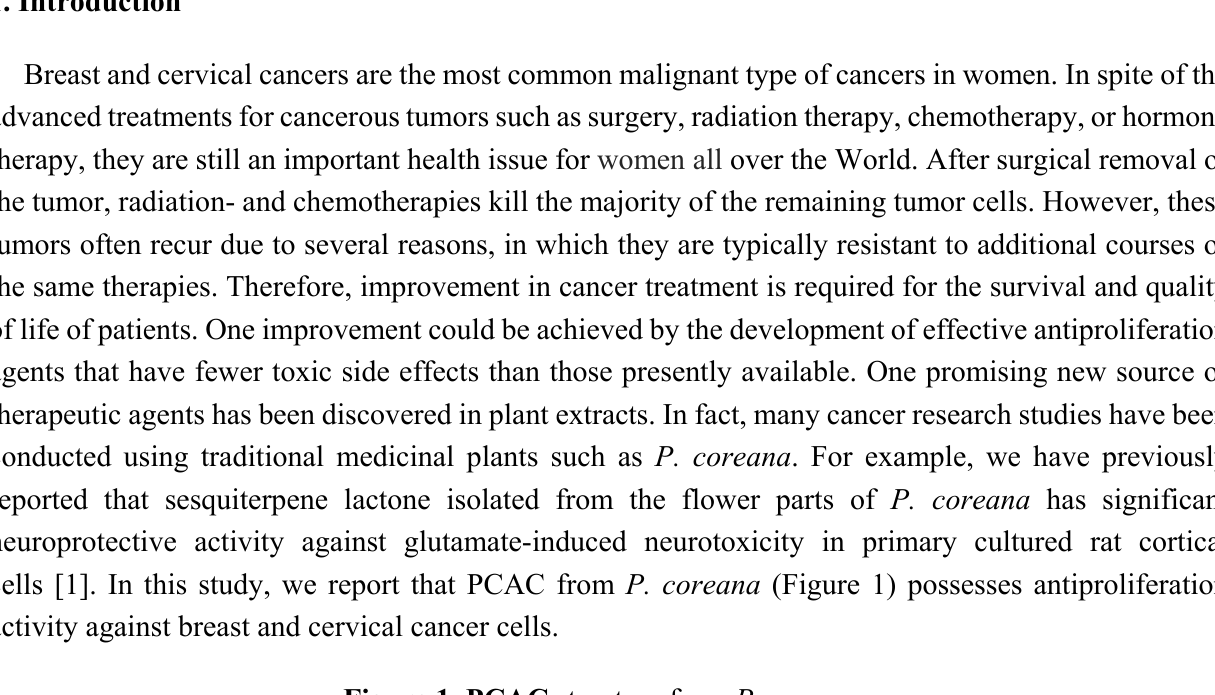
Figure 1. PCAC structure from P. coreana